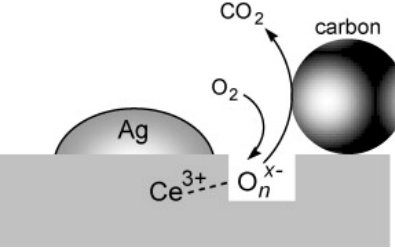
Figure 10. A schematic mechanism of soot oxidation over Ag/CeO 2 catalyst. Reproduced from Ref. [45] with the permission from the Elsevier.